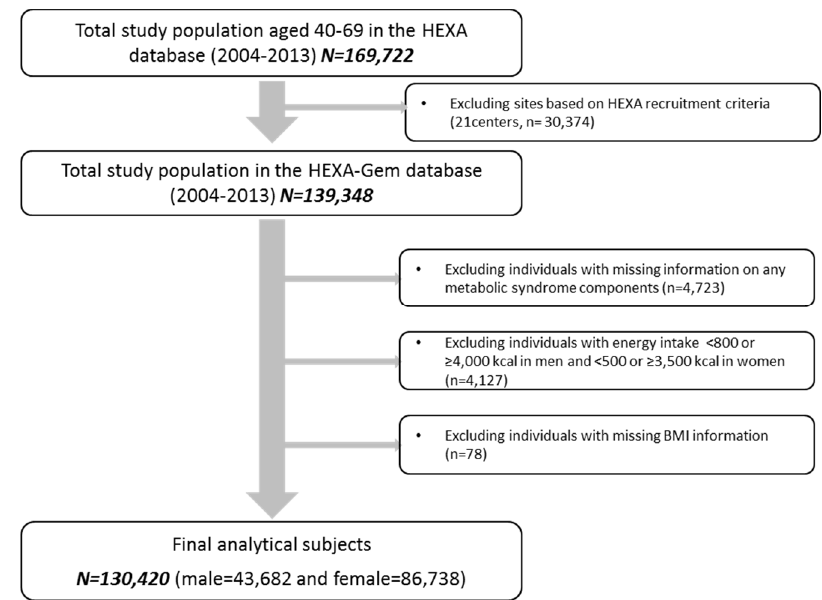
Figure 1. Flow diagram of analytical sample in the current study. HEXA, Health Examinees.